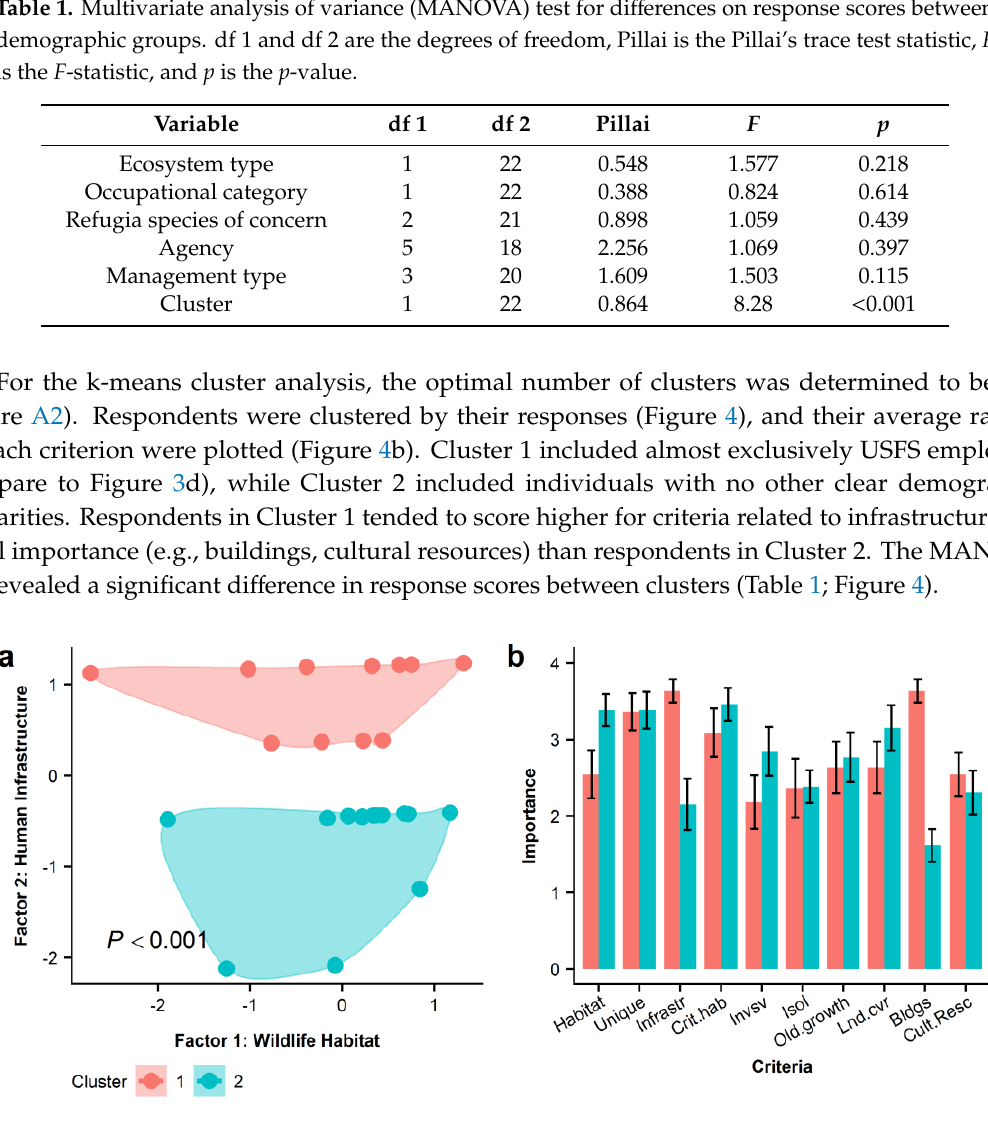
Figure 4. Respondent scores by cluster. ( a ) Respondents plotted along factors, grouped by cluster. ( b ) Mean and standard error of respondent importance rankings, by cluster. See Table A1 for descriptions of the abbreviations of the variables. p -values are from MANOVA tests, which test for differences between clusters by respondent’s scores.